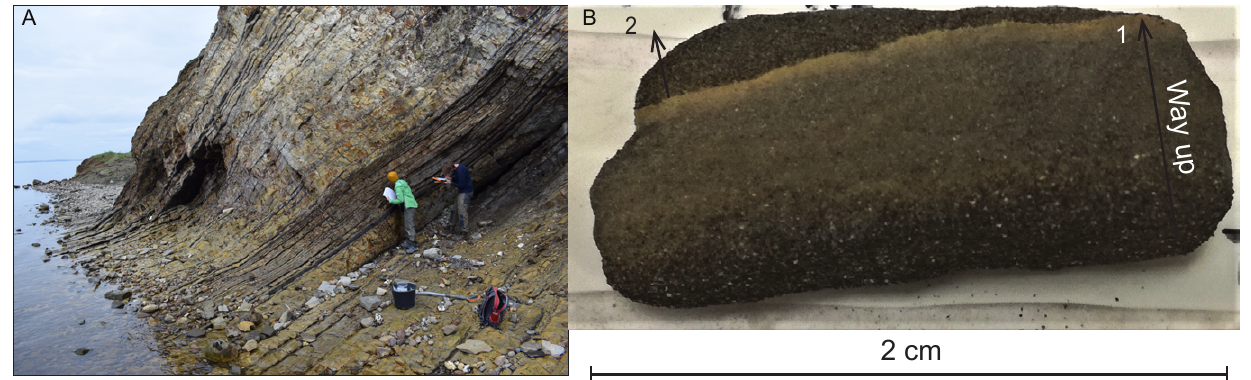
Figure 3: [A] Photo of the Knudeklint locality showing black ash layers of the positive series in light Fur For- mation diatomite. [B] An example of the normally graded character of the ashes. The picture shows the double basaltic ash layer ` 16 where the first (1) upward fining ash layer is immediately overlain by the coarse base of a second (2) ash layer.